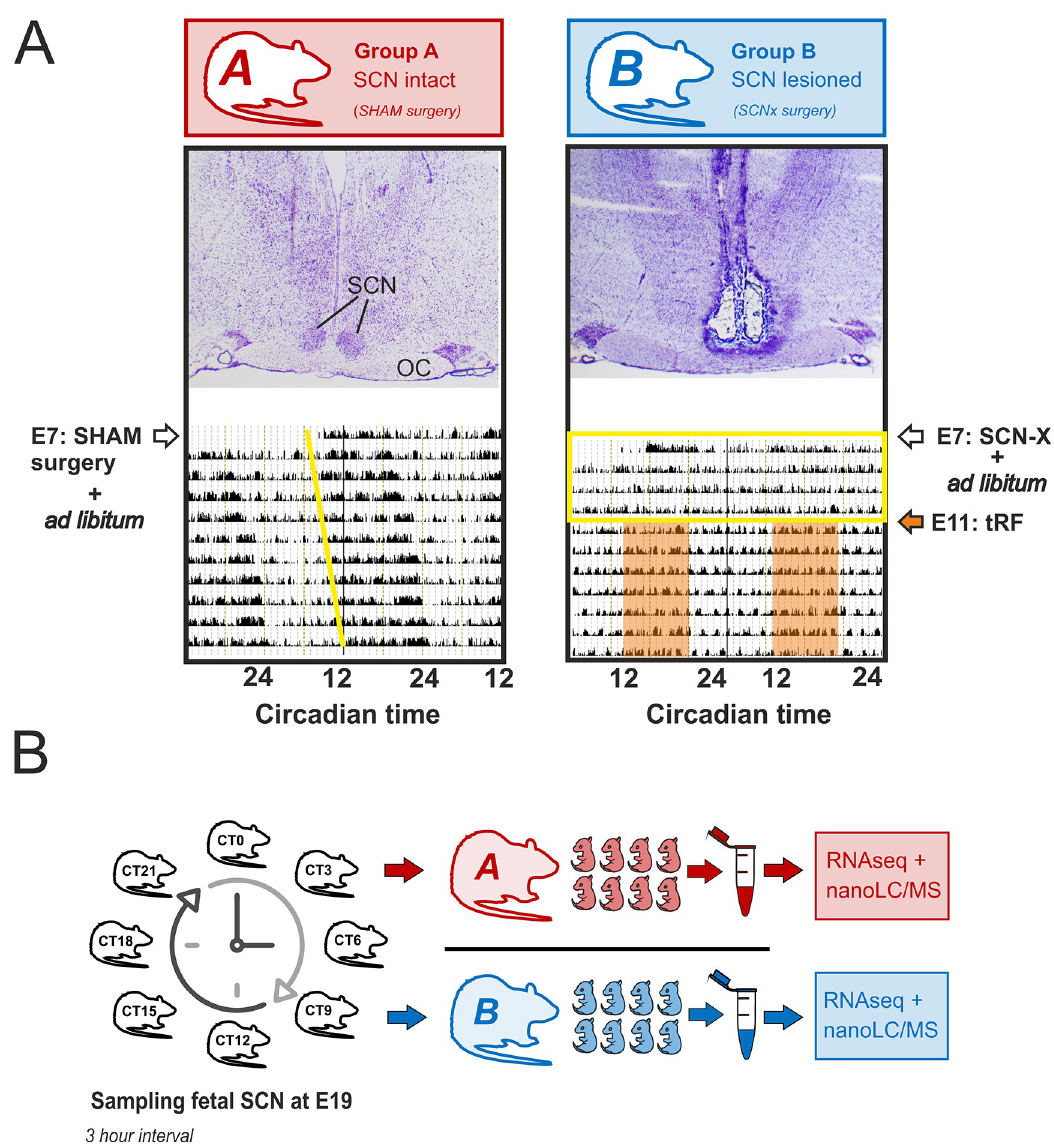
Fig 1. Schematic illustration of experimental design. A total of 32 pregnant rats were divided into 2 groups on the seventh gestational day (E7)—16 rats were exposed to the sham surgery (Group A; transcriptomic study: n = 8, proteomic study: n = 8) and 16 rats to the surgical procedure for the SCN ablation (Group B; transcriptomic study: n = 8, proteomic study: n = 8); both groups were maintained in constant darkness. (A) Representative histology of the brain sections through hypothalamic region containing the SCN of 1 sham-lesioned (SHAM; Group A) and 1 SCN-lesioned (SCN-X; Group B) pregnant rat and their locomotor activity (double-plotted actograms) recorded in constant darkness (DD) starting on the day of the surgery on embryonic day (E) 7 are shown (OC). Group A was fed ad libitum, while Group B had access to food for only 8 hours per day (tRF) starting from E11 (orange area) to impose a synchronous feeding rhythm on the SCN-lesioned arrhythmic animals. Yellow line in actogram of Group A shows the beginning of free-running locomotor activity in DD; the yellow rectangle in actogram of Group B depicts the interval between E7–E11 when the rats were arrhythmic due to the SCN lesion (used as an evidence for successful operation together with histology). (B) Rats were killed around the clock at E19; fetal SCN were collected and analyzed by transcriptomics and proteomics (for more details, see Materials and methods). OC, optical chiasm; SCN, suprachiasmatic nuclei; tRF, time-restricted feeding.